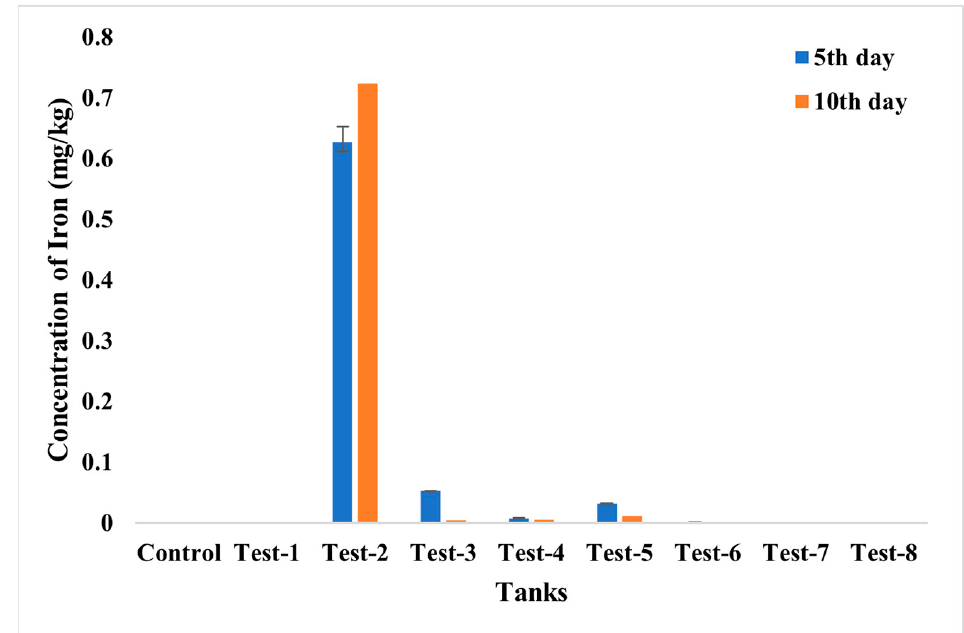
Figure 16. ICP—MS analysis for iron accumulation analysis in control; Test 1 —Chromium water;